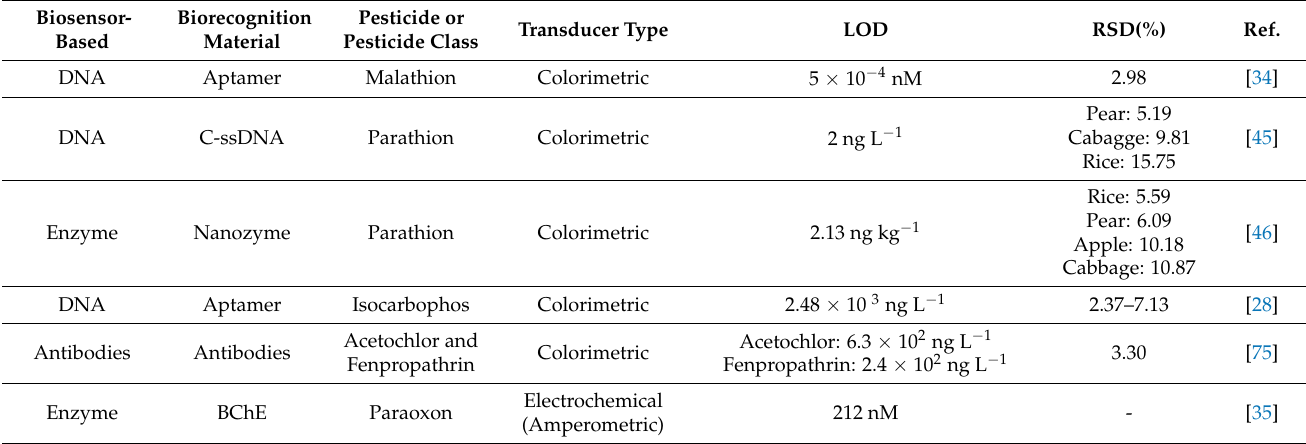
Table 3. Transducer-based biosensors for the detection of pesticides in